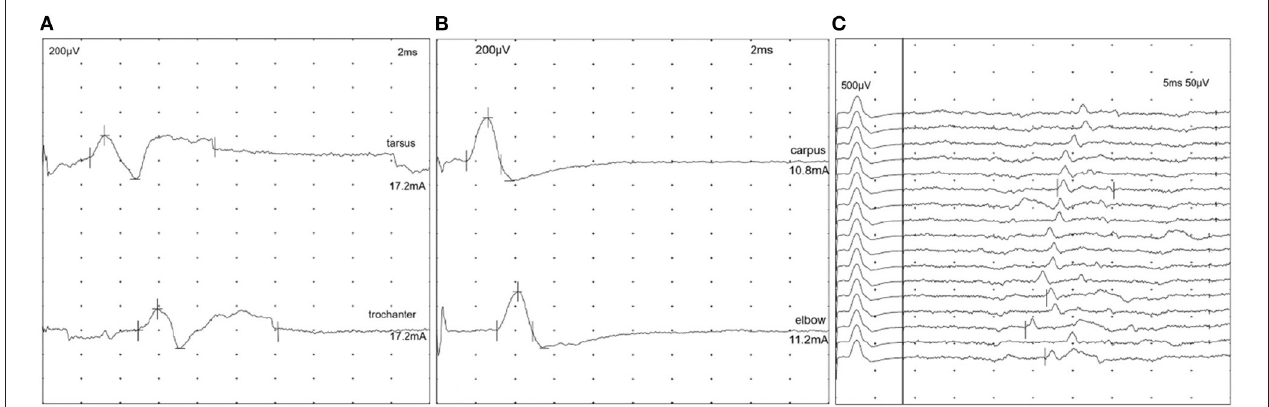
FIGURE 5 | Electrodiagnostic tests of a 14-months-old male Maine Coon cat with presumed immune-mediated polyneuropathy. (A) Motor nerve conduction studies of the left sciatic-tibial nerve. CMAPs show a marked reduction of amplitude/area and mild temporal dispersion. Motor nerve conduction velocity is 76 m/s [reference range 93.7 ± 9.4 m/s; Ref. ( 12)]. (B) Motor nerve conduction study of the right ulnar nerve. CMAPs show a marked reduction of amplitude/area. Motor nerve conduction velocity is 64 m/s [reference range 82.1 m/s ± 11.1 m/s; Ref. ( 12)]. (C) F-waves after supramaximal stimulation of the right ulnar nerve at the carpus.